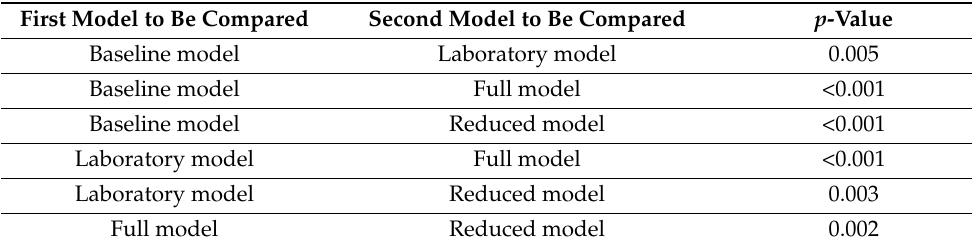
Table A3. Comparison of ROC * curves using DeLong’s test.